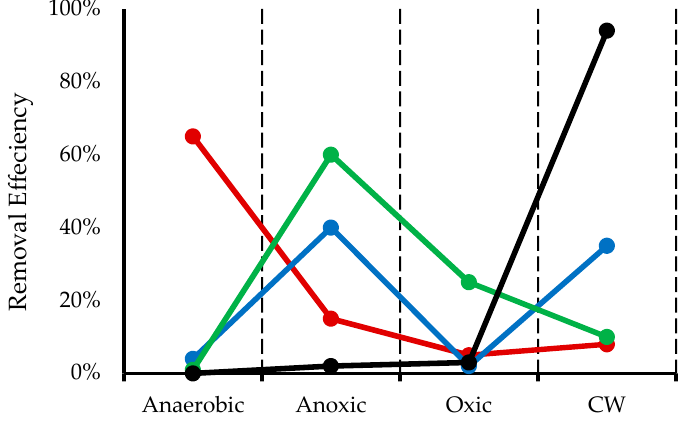
Figure 7. Removal efficiencies of COD, TN, NH 4+ –N, and TP in different units of A2O–wetland system. COD; TN; NH 4 –N; TP.